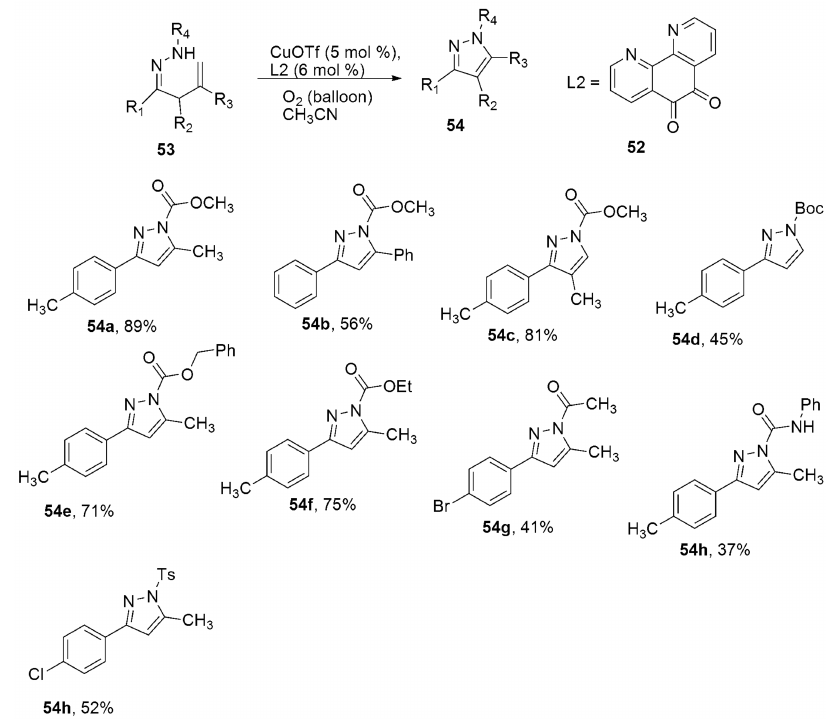
Scheme 13. Synthesis of the pyrazole derivatives from β , γ -unsaturated hydrazones [19]. The intermolecular, thermally activated, and DBU-aided [3 + 2] cycloaddition of pyridin-2-yl- [1,2,4]-triazine dipolarophiles 55 with structurally varied 4-methylbenzenesulfonohydrazides 24 produced 57 as the major isomer with an excellent yield [20] (see Scheme